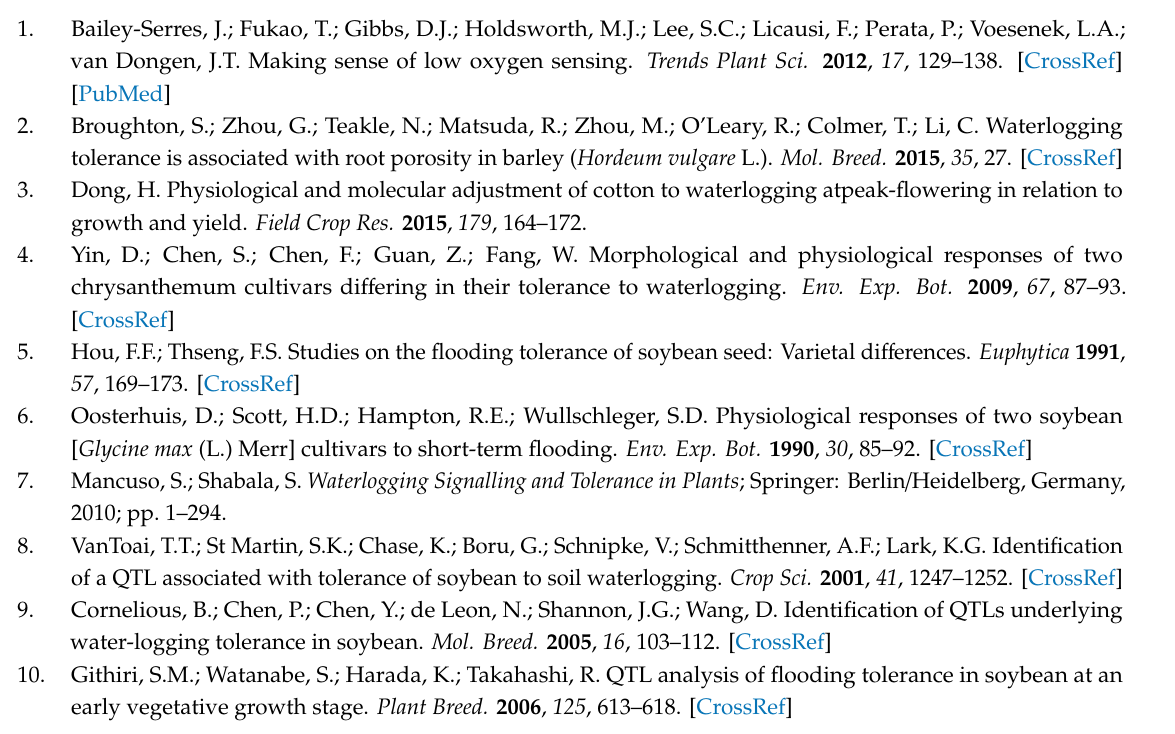
Supplementary Materials: The supplementary materials are available online at http: // www.mdpi.com / 2073-4425 / 10 / 12 / 957 / s1, Table S1: List of 347 soybean lines and the evaluation of GR, NSR and EC in two environments JP14 and HY15, Table S2: Primers used in this study, Table S3: Analysis of variance (ANOVA) of GR and NSR among four lines under di ff erent times of flooding treatment, Table S4: SNPs contained in the candidate region on Chr.13, Table S5: Phenotypic data of three selected seed-flooding tolerant and sensitive lines used in qRT-PCR and sequencing analysis, Table S6: Phenotypic correlations ( r ) among GR, NSR and EC in two di ff erent environments. Author Contributions: Conceptualization, T.Z.; Data curation, Z.Y.; Formal analysis, Z.Y. and F.C.;